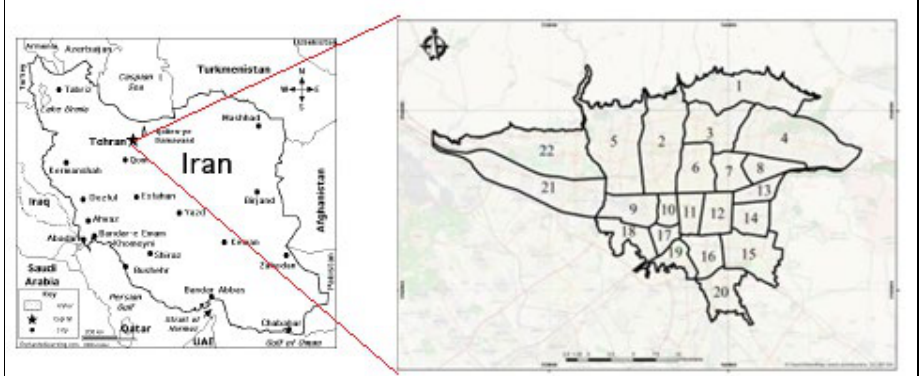
Fig. 1: The map of Tehran along with 22 districts